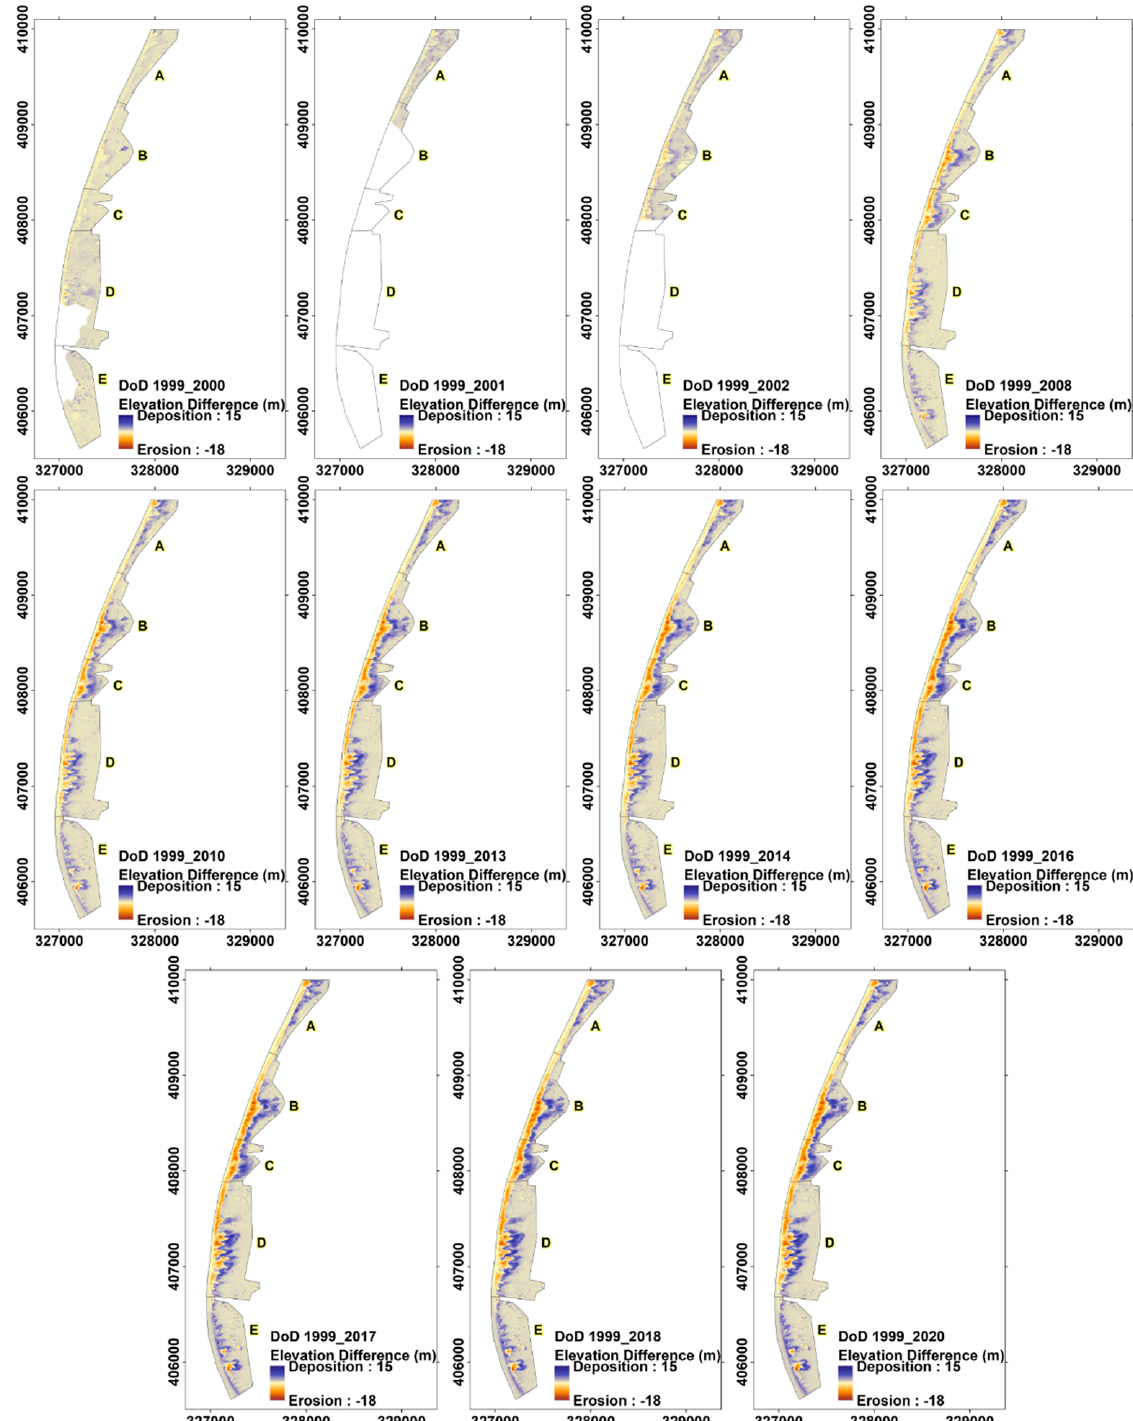
Figure 3. Formby elevation difference maps. These maps show the vertical changes in the dunes that occur between each year DTM and the primary DTM of 1999. DTMs of 2000, 2001, and 2002 do not cover the whole study area. Progressively increasing erosion is observed in the frontal dunes of zones B, C, and D, in addition to the north part of zone A. Areas to the east of these frontal dunes have seen significant deposition, while the frontal dunes of zone E have also seen similar deposition.